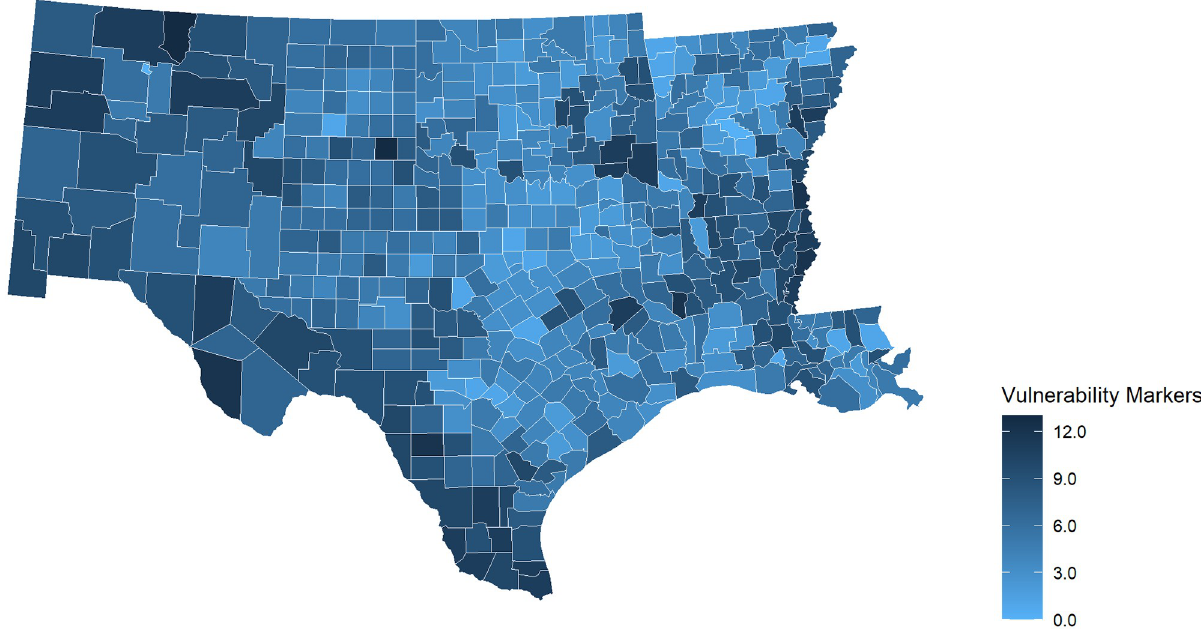
Fig 3. Markers of medical, economic, and geographic vulnerability, HHS Region 6, 2017 Arkansas, Louisiana, New Mexico, Oklahoma, Texas. Map prepared using R’s open source package, usmaps, developed by Paolo Di Lorenzo under a GNU General Public License (GPL), Version 3 (https:// cran.r-project.org/package=usmap).